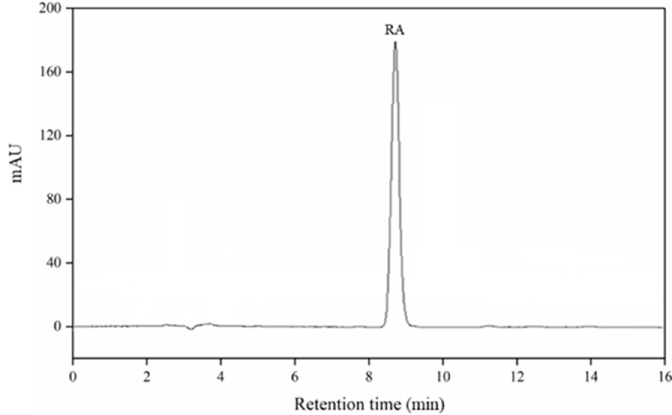
Figure 4. HPLC chromatogram of the solid phase after first crystallization at 210 nm wavelengths.